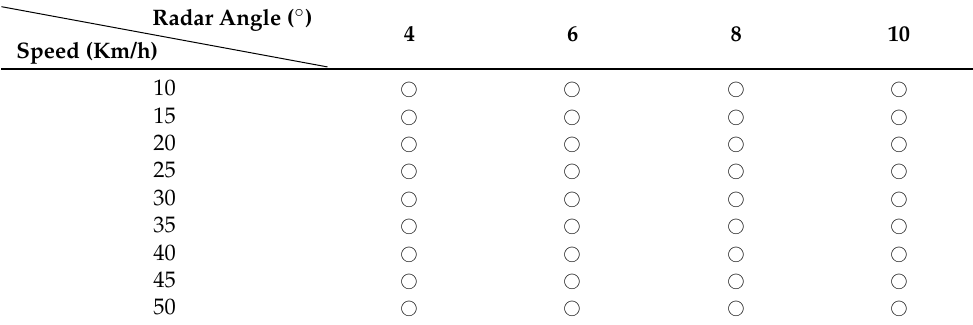
Table 2. AEBS city scenario